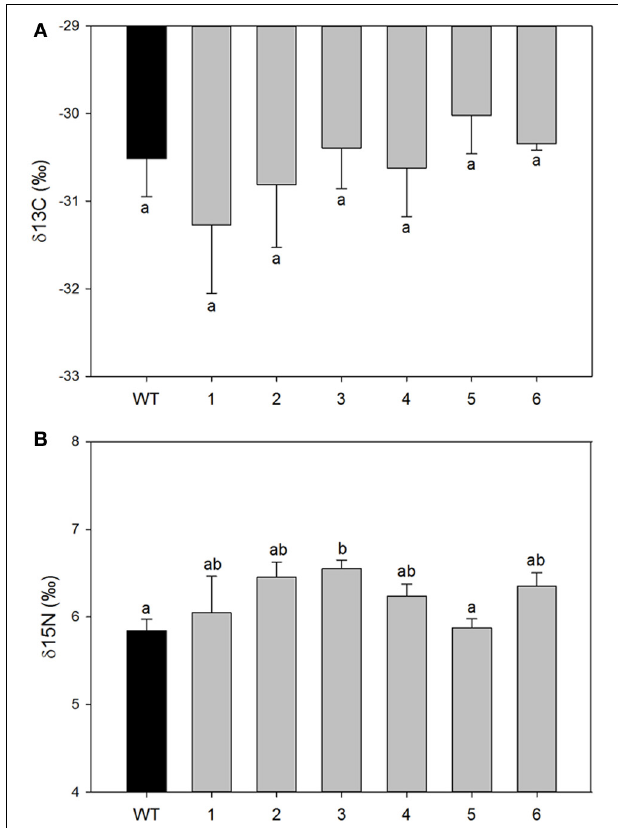
FIGURE 4 | Isotopic composition of carbon (A) expressed as δ 13 C and nitrogen (B) expressed as δ 15 N in leaves collected from wild-type and transgenic lines. Each histogram is the average of all available plants from transgenic lines ( n = 3–8); the error bars represent SE. There were no differences among control and transformed plants in δ 13 C signature. Letters denote homogeneous groups based on Fisher LSD method.